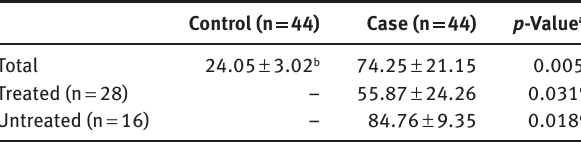
Table 2: Mean IL-33 plasma levels in MS and control